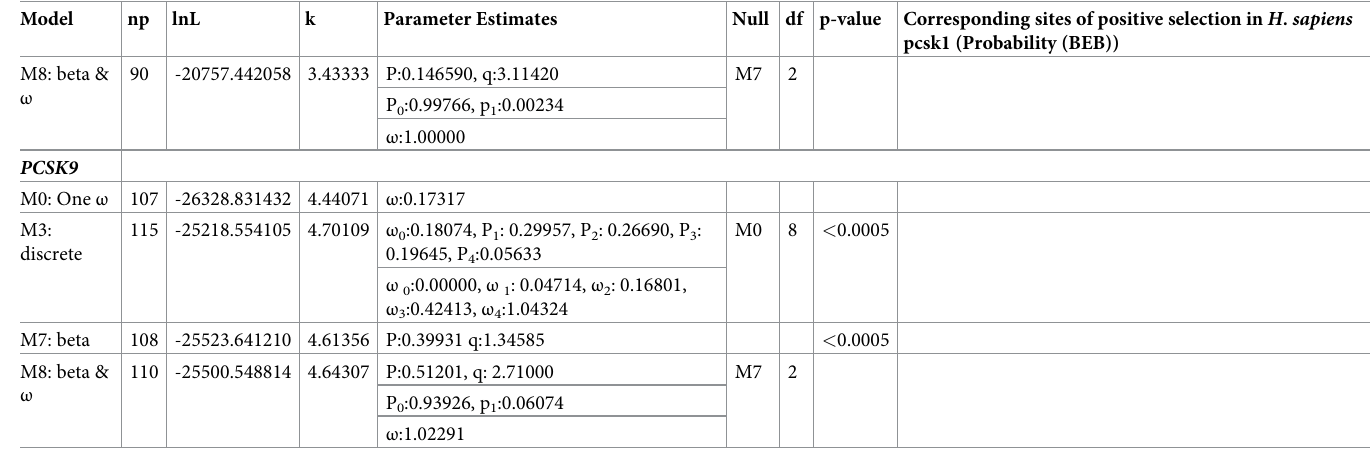
dine, and tryptophan at this location. The substitution of glutamine at position 1150 by trypto- 0.014) (S5 Table). At position 1442, only Pongo abelii (sumatran orangutan) and Homo